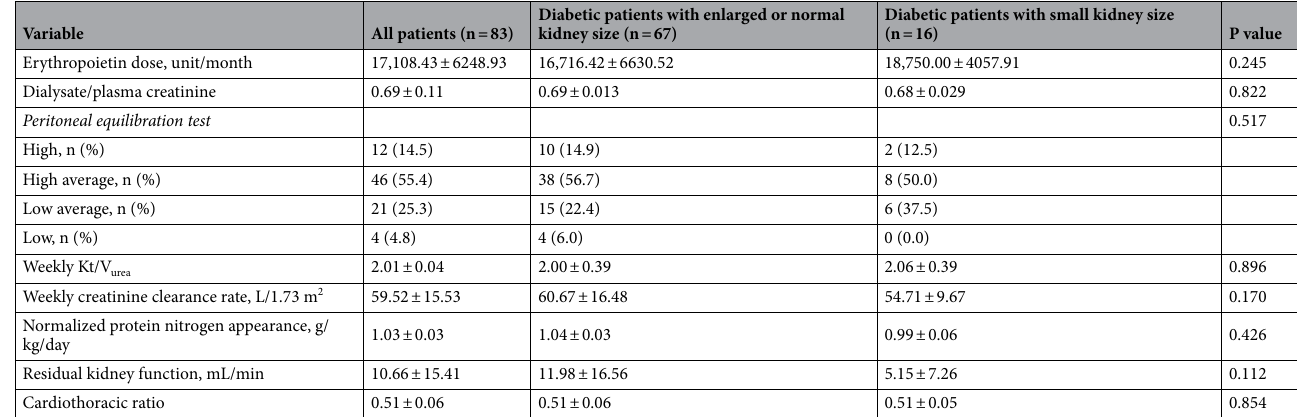
Table 3. Dialysis-related data of peritoneal dialysis patients stratified by kidney size (n = 83). Residual kidney function was determined by urinary creatinine clearance using a 24-h urine collection method. Cardiothoracic ratio was measured by dividing the biggest transverse diameter of the heart silhouette by the length between the internal margins of the ribs at the level of right